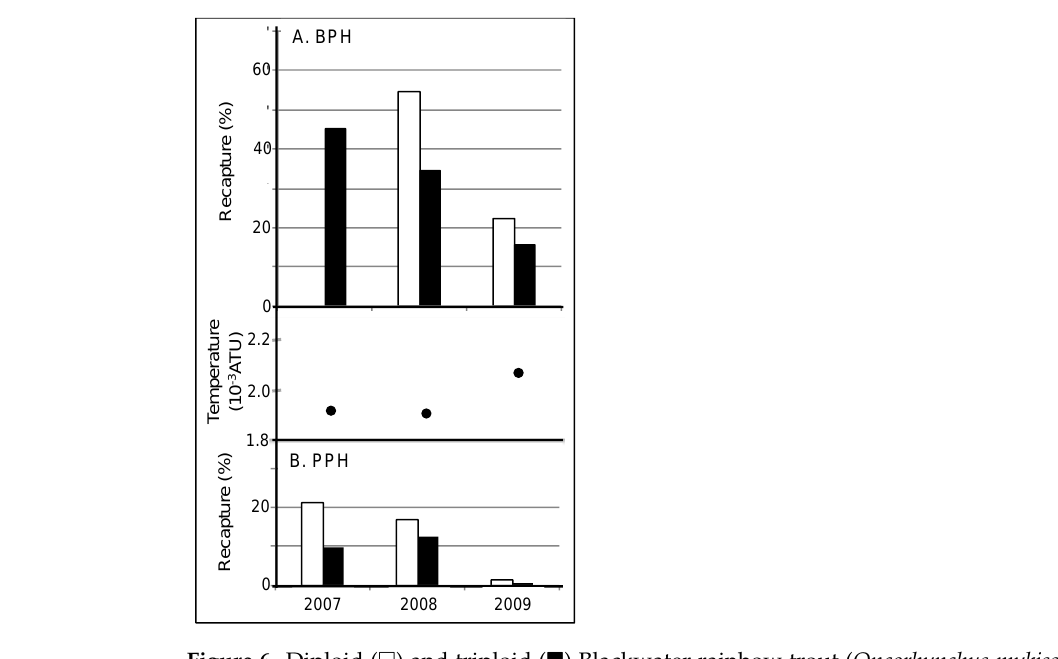
Figure 6. Diploid (□) and triploid ( ■ ) Blackwater rainbow trout ( Oncorhynchus mykiss ) recapture in Pete’s Pothole (PPH; a warm lake with avian piscivores prevalent) ( A ) and Bluey Pothole 2 (BPH; a cool lake with lower avian piscivore prevalence) ( B ) in the summers of 2007, 2008 and 2009. (●): accumulated thermal units (ATU) calculated across June, July and August of each year based on Merritt, British Columbia air temperatures obtained from the Environment Canada database. Table 2. Endurance (mean ± SEM) of the 1st, 2nd and 3rd 2N and 3N quartiles of Blackwater rainbow trout ( Oncorhynchus mykiss ) to fail during endurance swimming tests in 2008 (n = 500 in each of two endurance tests).